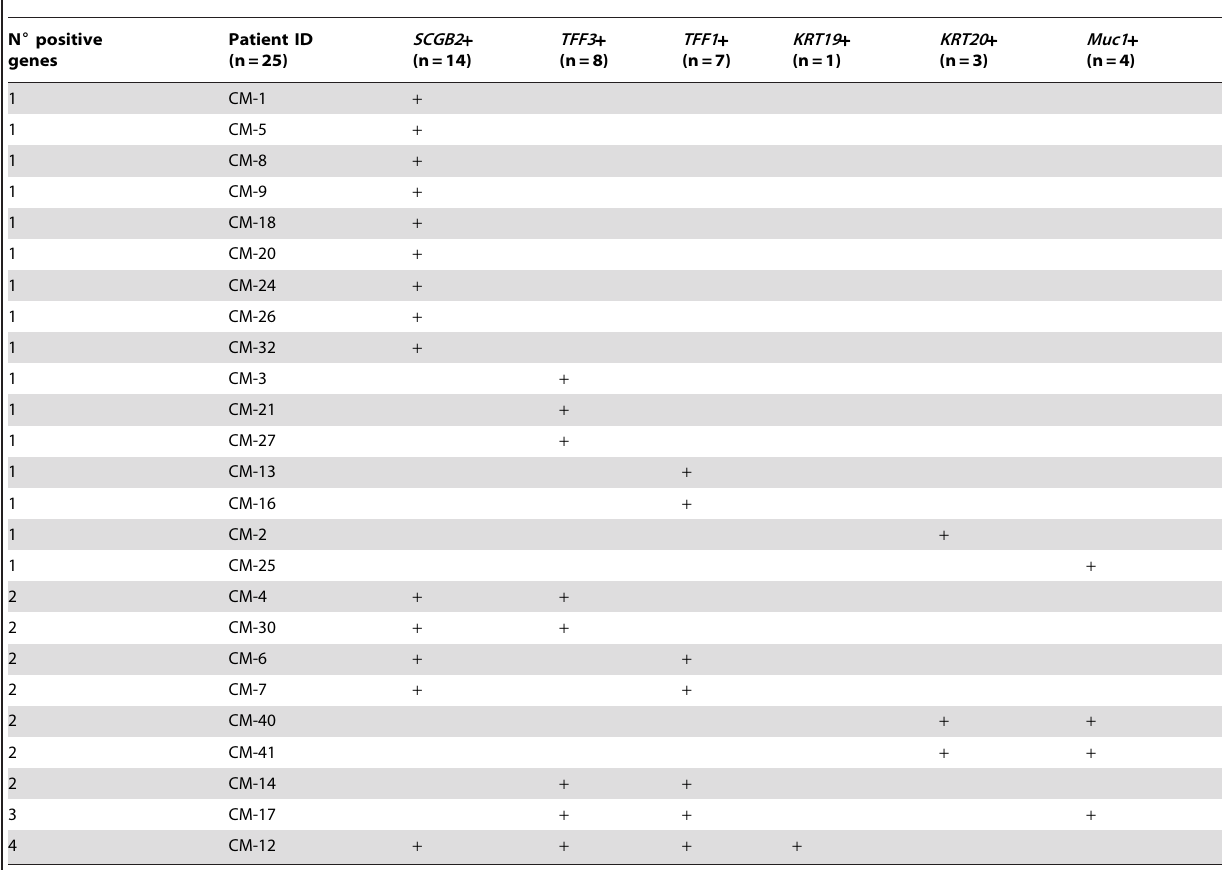
Number of samples with positively and negatively expressed SCGB2 and its association with the other markers. Sixteen patients were positive for 1 of the genes: 9 for SCGB2 , 3 for TFF3 , 2 for TFF1 , 1 for KRT20 and 1 for Muc1 . Seven patients were positive for 2 genes: 2 for SCGB2 + TF3 , 2 for SCGB2 + TFF1 , 2 for KRT20 + Muc1 and 1